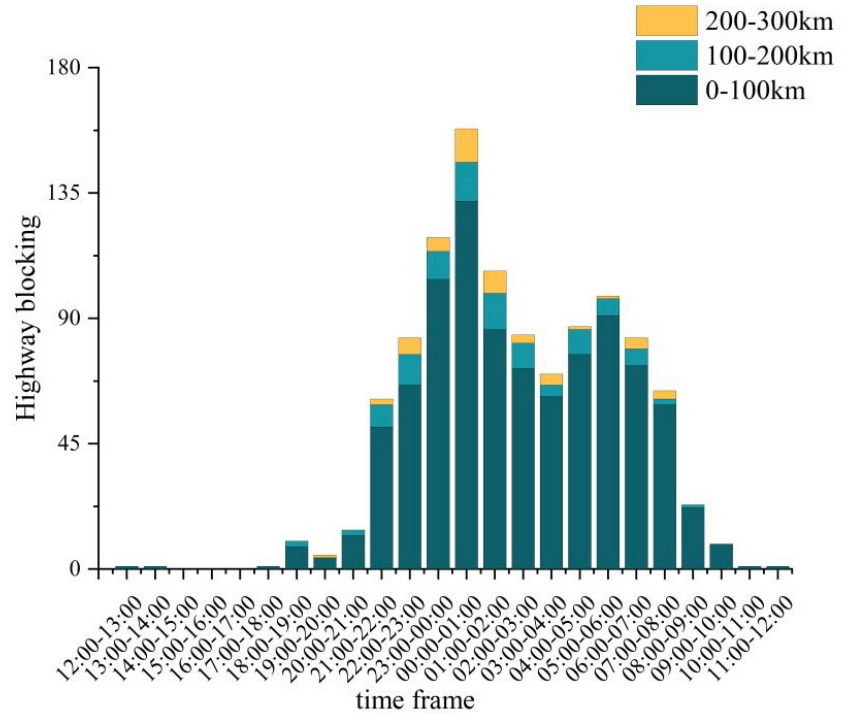
Figure 6. Diurnal variation of the annual average frequency of highway-blocking events in Jiangsu Province in 2020.